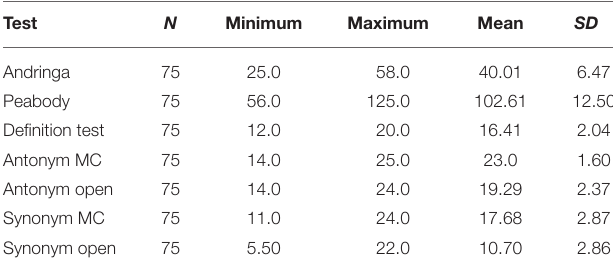
TABLE 1 | Test scores in seven vocabulary tests.